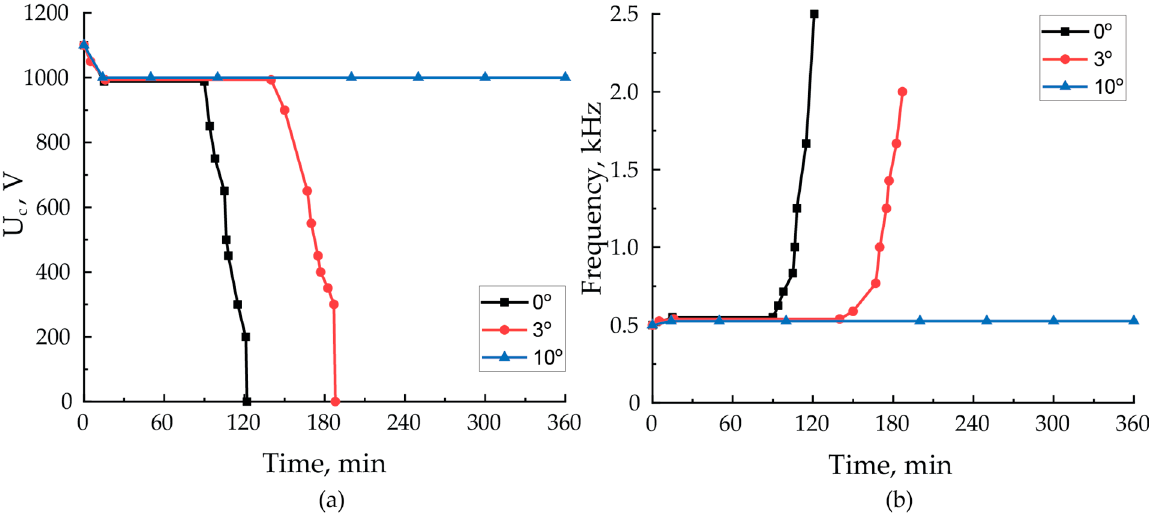
Figure 9. The dependences of ( a ) the capacitor charging voltage and ( b ) the frequency of capacitor discharges for the case of synthesis with the UDP for electrodes’ ends arranged in parallel and at the angles of 3° and 10°.